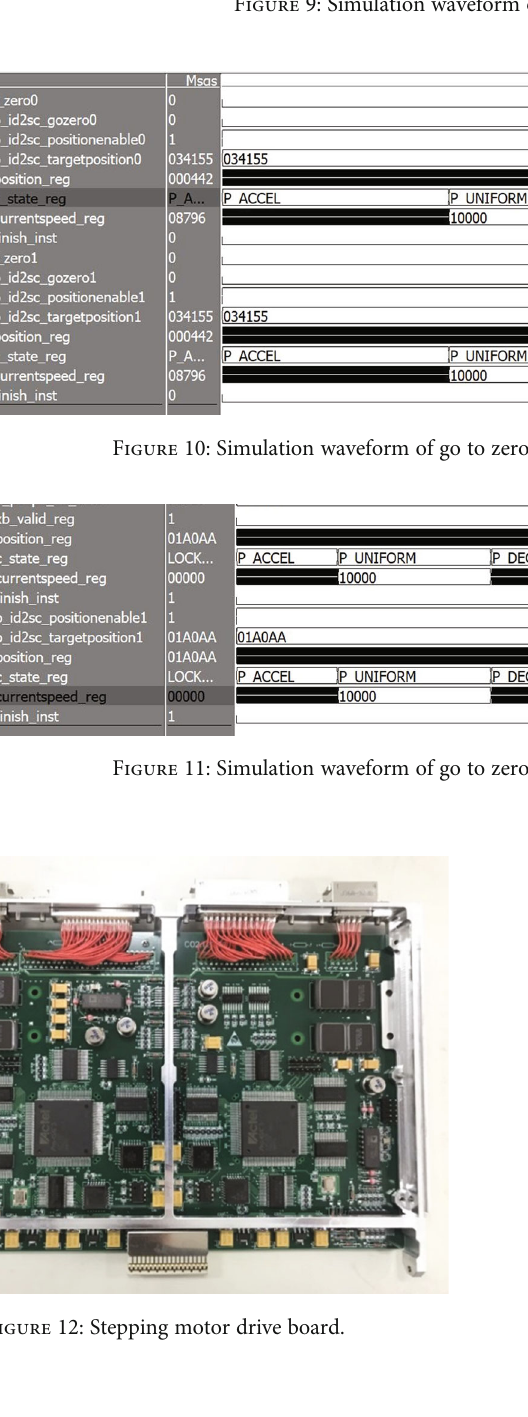
Figure 9: Simulation waveform of 235 ° angle regulation.